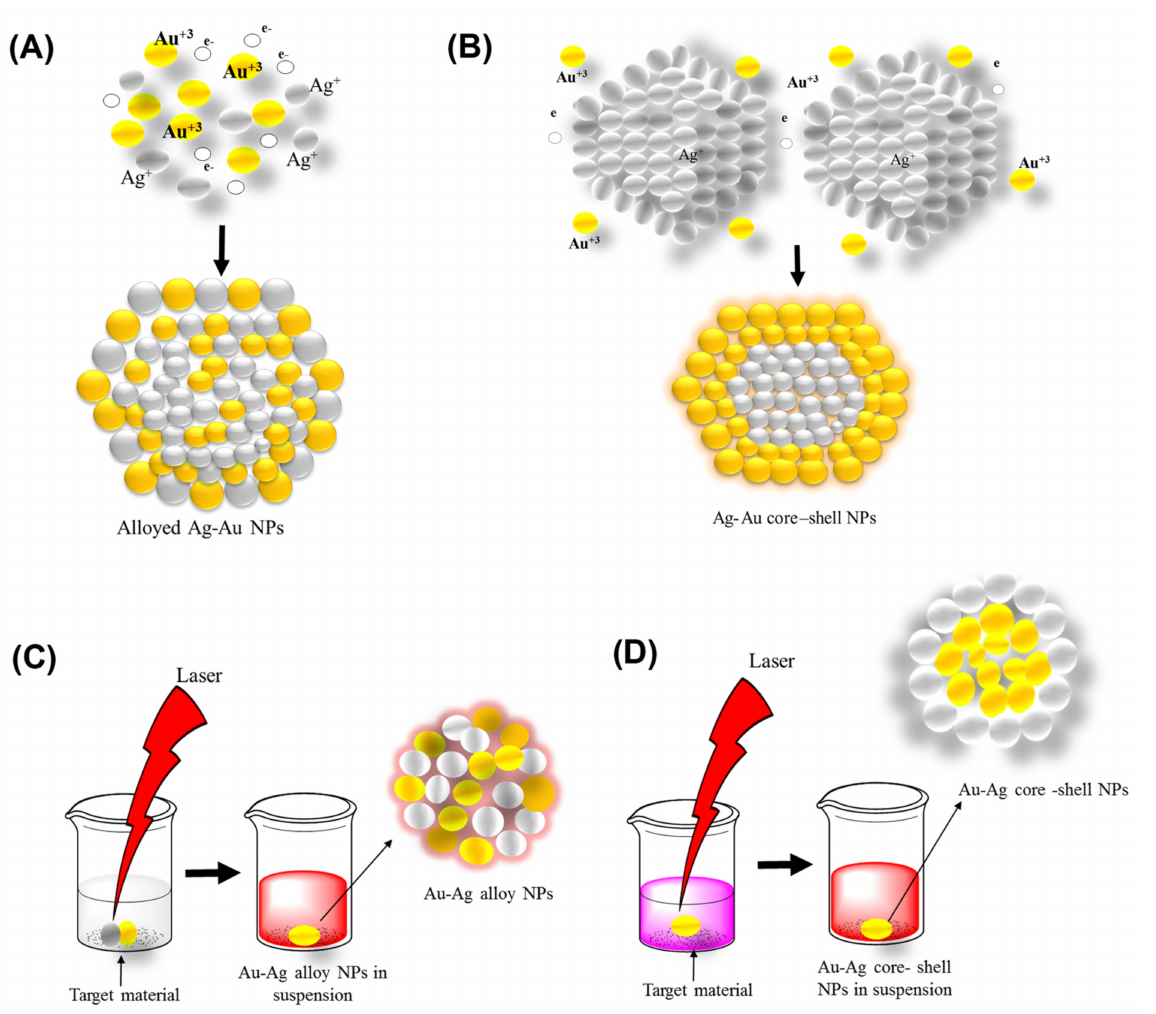
Figure 6. ( A ) Co-reduction method for synthesis of nanomaterials, ( B ) Seeded growth method for Au–Ag NPs synthesis, ( C ) Au–Ag NPs synthesis via simultaneous laser ablation of Ag and Au, ( D ) Au–Ag NPs synthesis by ablation of Ag in Au NP